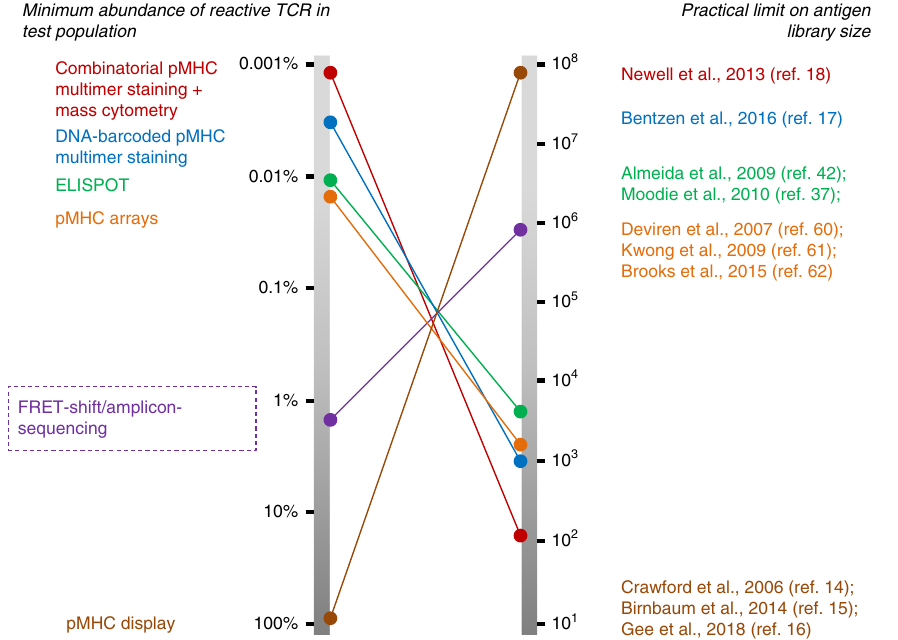
Fig. 7 Comparison of our strategy with methods currently in use for T-cell antigen discovery. The methods currently constituting the suite of approaches available currently for T-cell antigen screening as well as our FRET-shift/amplicon-sequencing methodology are mapped with respect to their robustness in detecting T-cell antigens from highly mixed T-cell populations (left) and their ability to screen high-diversity libraries of candidate antigens (right) 14 – 18,37,42,60 – 62 . It will be possible to place the recent methods described by Li et al. 47 , Joglekar et al. 48 , and Kisielow et al. 49 on these spectra when data are published showing method sensitivity with respect to polyclonality of input T-cell populations and complexity of input antigen